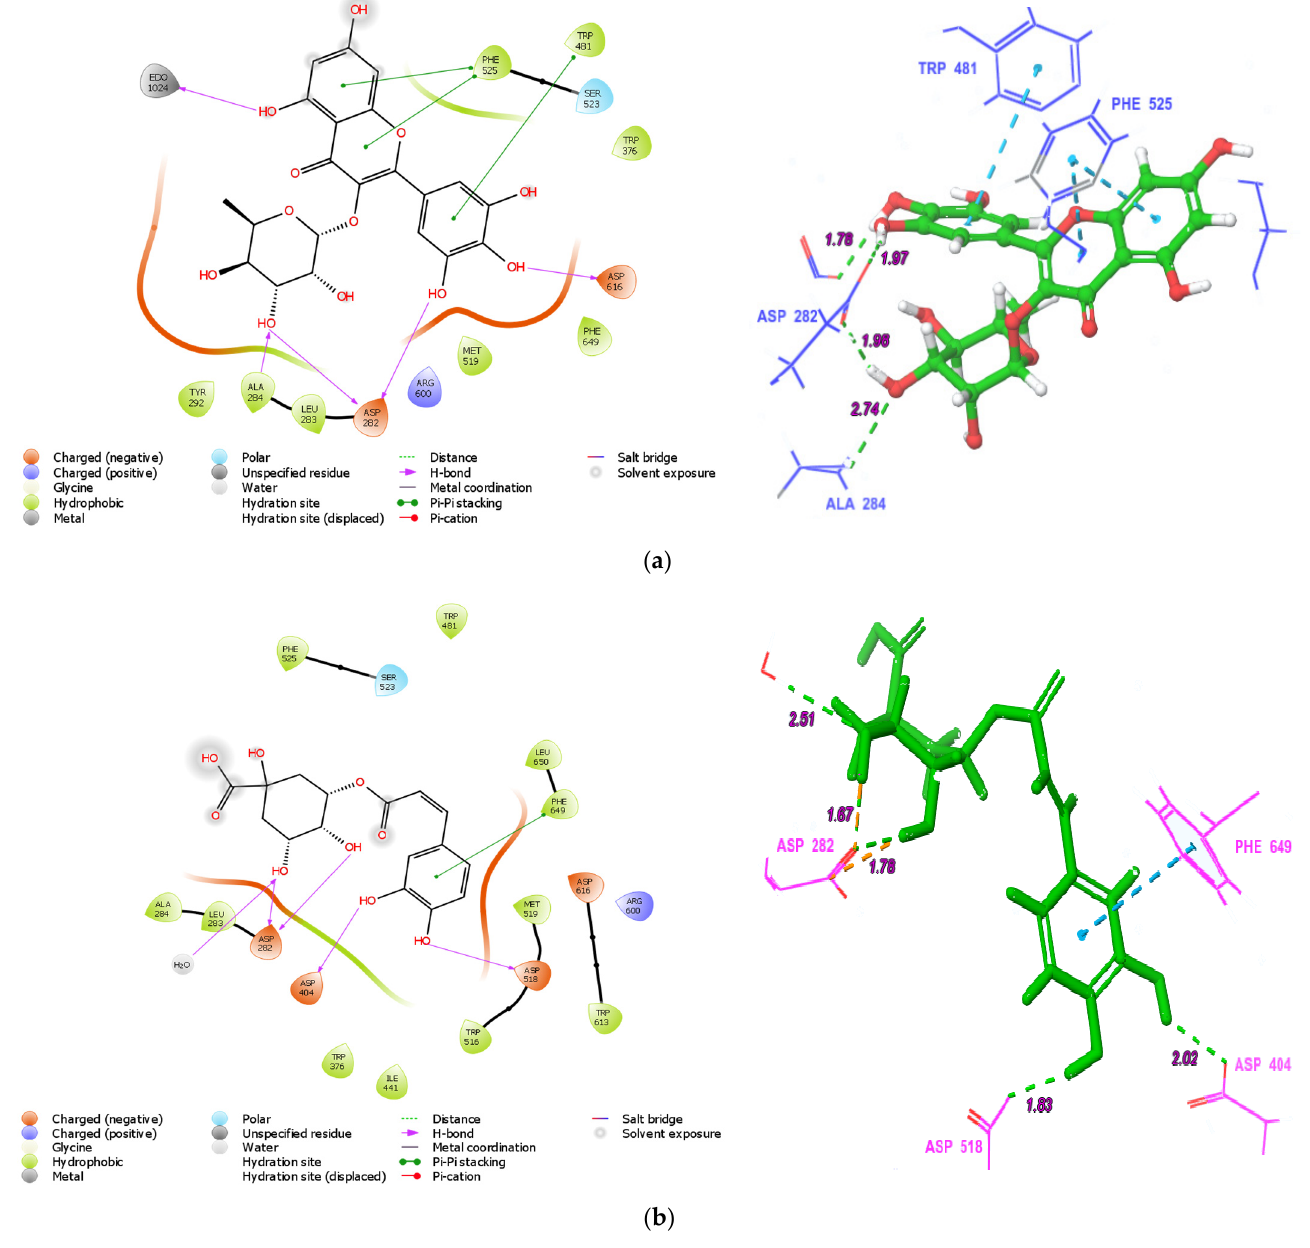
Figure 4. ( a ) The estimated binding geometry (2D (left) and 3D (right)) of myricitrin in 5NN8. The active side residues are named with three letters. ( b ) The estimated binding geometry (2D (left) and 3D (right)) of chlorogenic acid in 5NN8. The active side residues are named with three